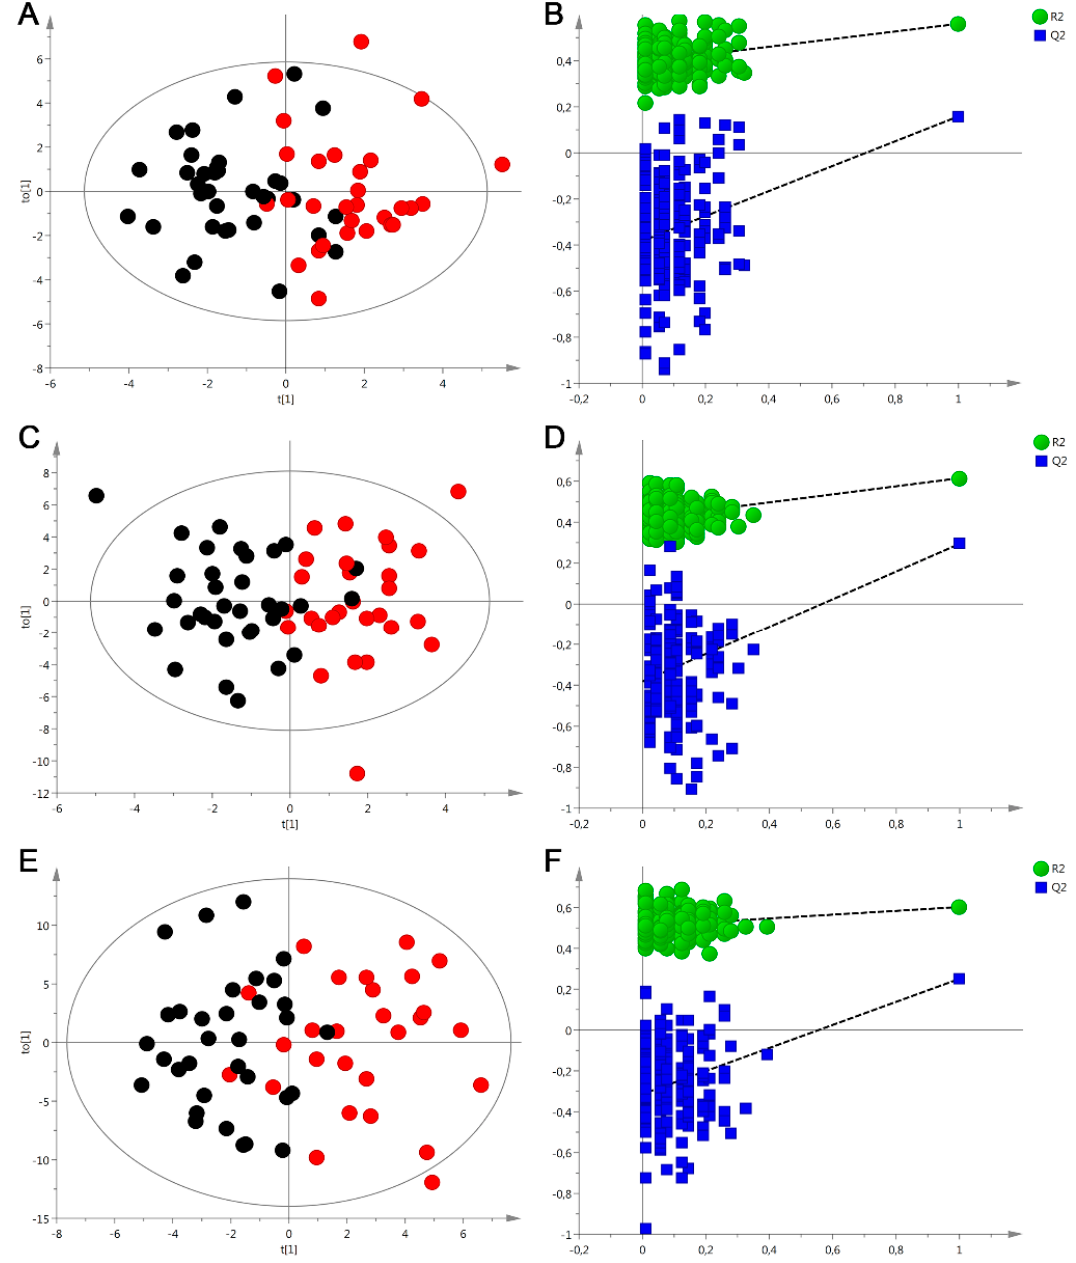
Figure 2. Multivariate analysis of metabolomics data from hypertensive patients (red dots) and normotensive patients (black dots). ( A ) Orthogonal partial least squares discriminant analysis (OPLS-DA) score plot of plasma 1 H NMR data; ( B ) plot obtained after performing random permutation test with 200 permutations on OPLS-DA model of plasma data; ( C ) OPLS-DA score plot of interstitial fluid 1 H NMR data; ( D ) plot obtained after performing random permutation test with 200 permutations on OPLS-DA model of interstitial fluid data; ( E ) OPLS-DA score plot of urine 1 H NMR data; ( F ) plot obtained after performing random permutation test with 200 permutations on OPLS-DA model of urine data.